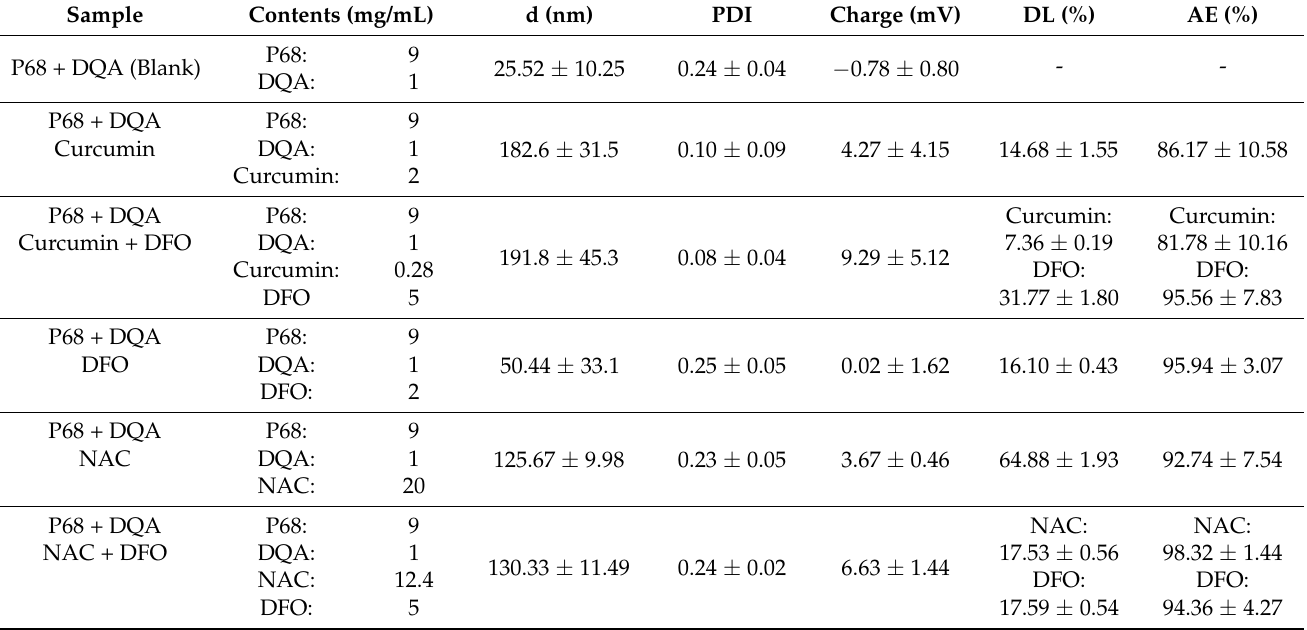
Table 1. Hydrodynamic Diameter (d), Polydispersity Index (PDI), Surface Charge, Drug Loading (DL) and Association Efficiency (AE) of blank and drug-loaded P68 + DQA nanoformulations prepared at and 80 ◦ C (mean ± S.D., n = 6) as previously reported in Mursaleen et al.